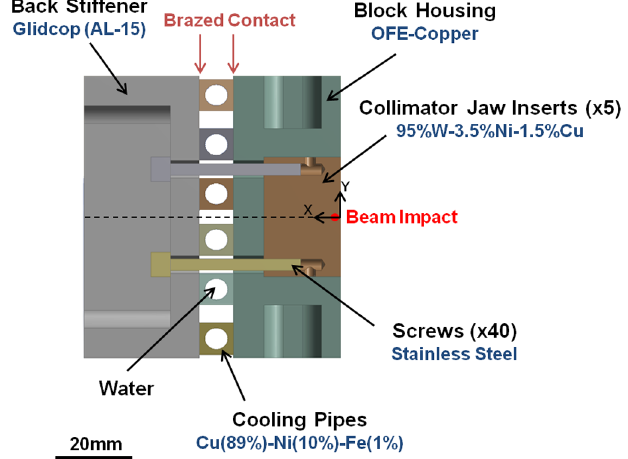
FIG. 4. A detailed cross-sectional view in the x - y plane of the horizontal TCT left jaw assembly, together with the location of the considered beam